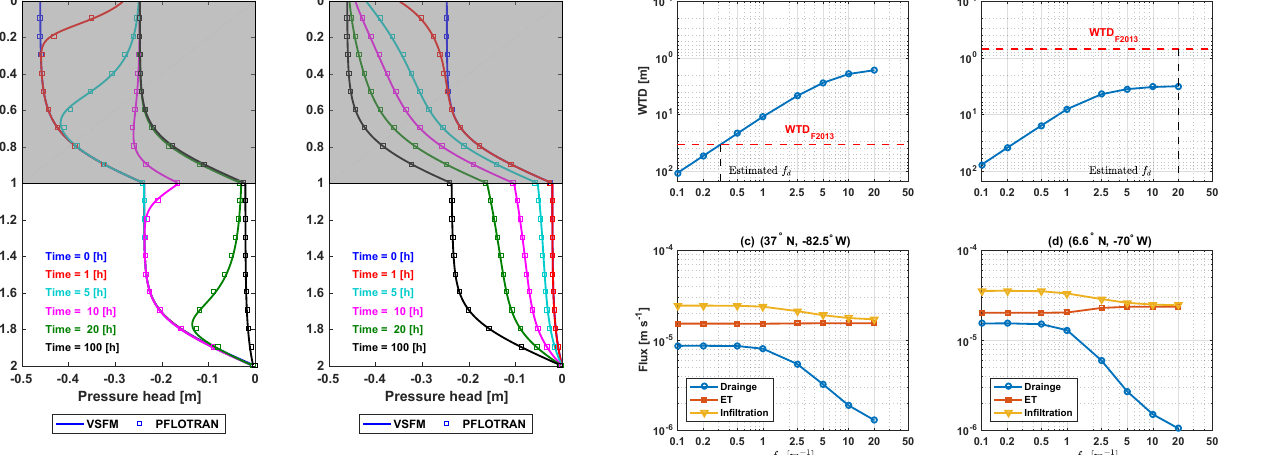
Figure 4. (a–b) The nonlinear relationship between simulated water table depth (WTD) and f d for two grid cells within ELM’s global grid. WTD from the Fan et al. (2013) dataset and optimal f d for the two grid cells are shown with dashed red and dashed black lines, respectively. (c–d) The simulated drainage, evapotranspiration, and infiltration fluxes as functions of optimal f d for the two ELM grid cells.